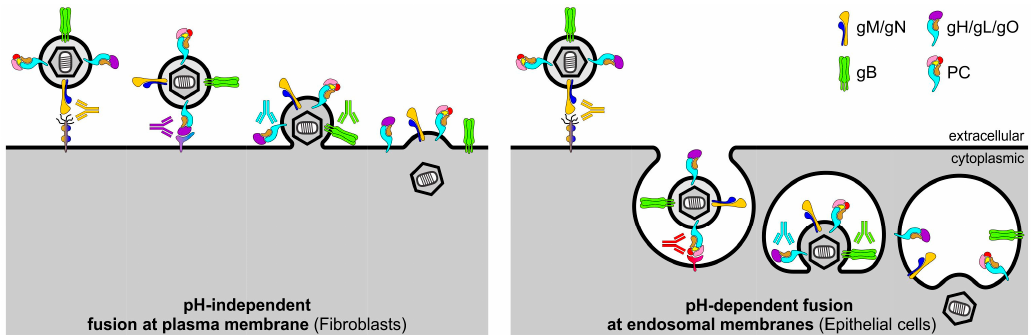
Figure 2. Model of HCMV entry routes and antibody interference. While HCMV entry into FB occurs by fusion at the plasma membrane, HCMV infection of EC is mediated by fusion at the endosomal membrane following endocytosis. During FB and EC entry, initial attachment may be mediated by gM/gN. Receptor-binding during FB entry is thought to occur by interaction of gH/gL/gO with PDGFR α . In contrast, receptor-binding during EC infection is mediated by interaction of the PC with an unknown molecule, which may in turn trigger PC-mediated endocytosis. Upon receptor-binding, gB and gH/gL/gO are thought to be involved in the fusion of the virion envelope with cellular membranes, which may occur either at the plasma membrane during FB entry or at endosomal membranes during EC entry. While NAb targeting gM/gN may interfere with the initial attachment, NAb targeting specific epitopes of gH/gL/gO or the PC may block receptor-binding during FB or EC entry, respectively. In addition, NAb targeting gH/gL/gO and gB may interfere with fusion of the virion envelope and cellular membranes.